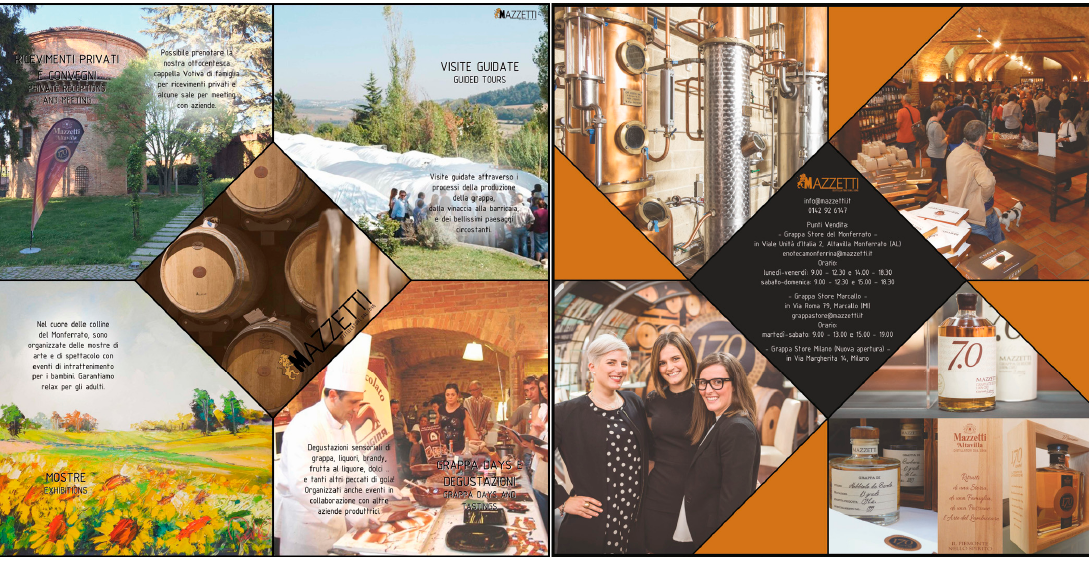
Figure 4. Front and back of one of the innovative brochures of Distilleria Mazzetti d’Altavilla realized for the promotion of cultural events and